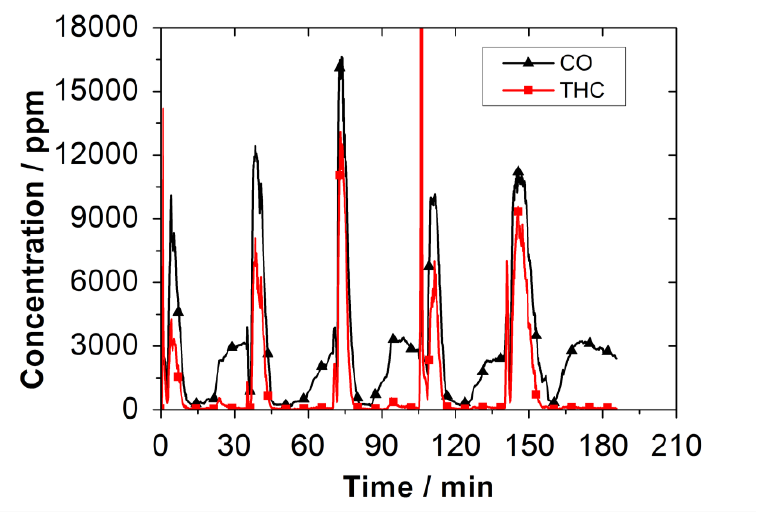
Figure 1. Carbon monoxide (CO) and total hydrocarbon (THC) concentration in the exhaust gas during several burning cycles in the wood log stove used during experimentation.